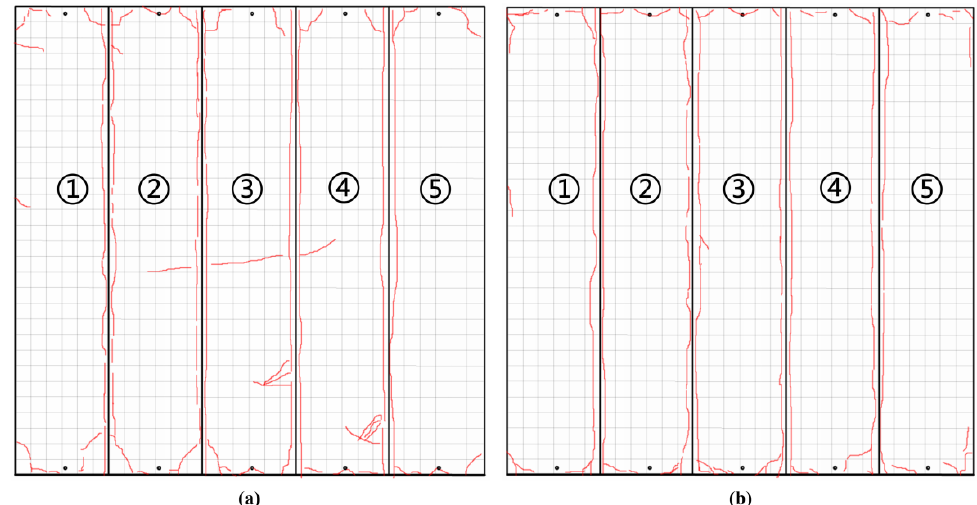
Figure 14. Diagrams depicting the wall panel cracks in specimens SF-1 ( a ) and SF-2 ( b ). The crack distribution of the wall panel in specimen SF-2 is shown in Figure 14b.